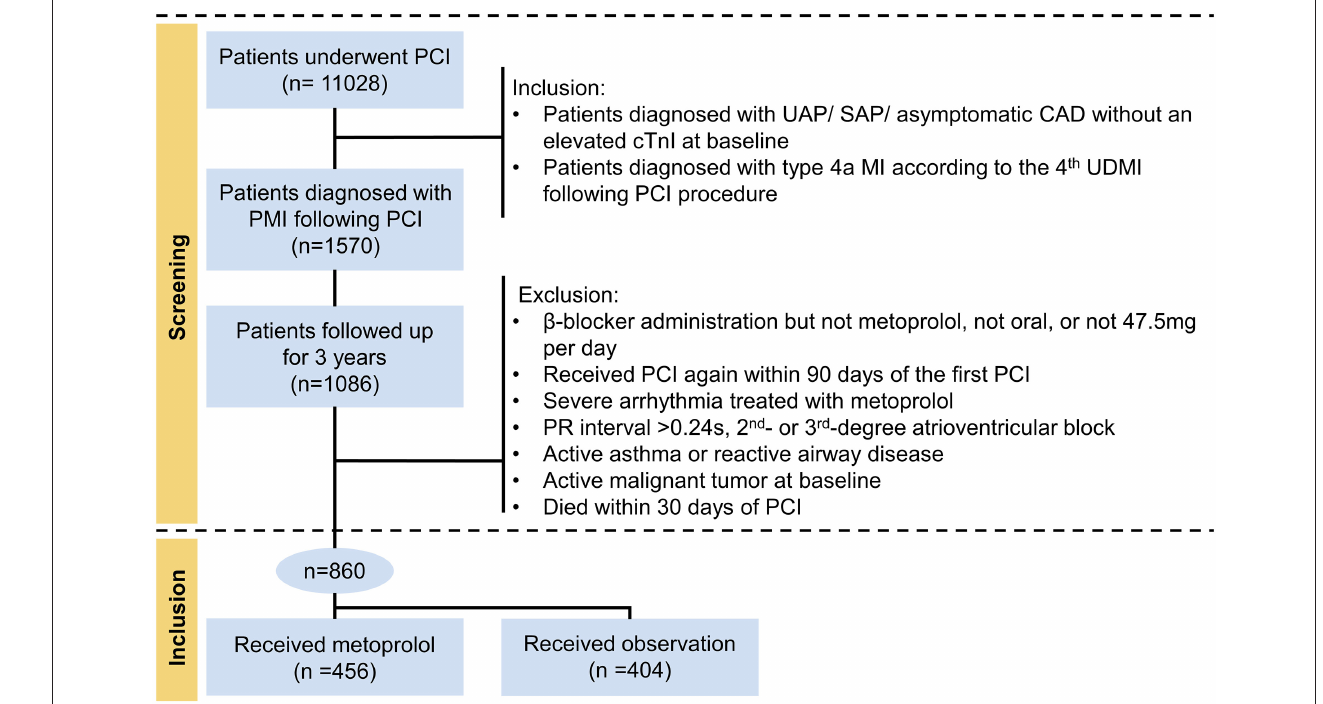
FIGURE 1 | Flowchart describing the selection of subjects. ULN, the upper limit of normal; cTnI, cardiac troponin I; PCI, percutaneous coronary intervention; PMI, periprocedural myocardial infarction; UAP, unstable angina pectoris; SAP, stable angina pectoris; CAD, coronary artery